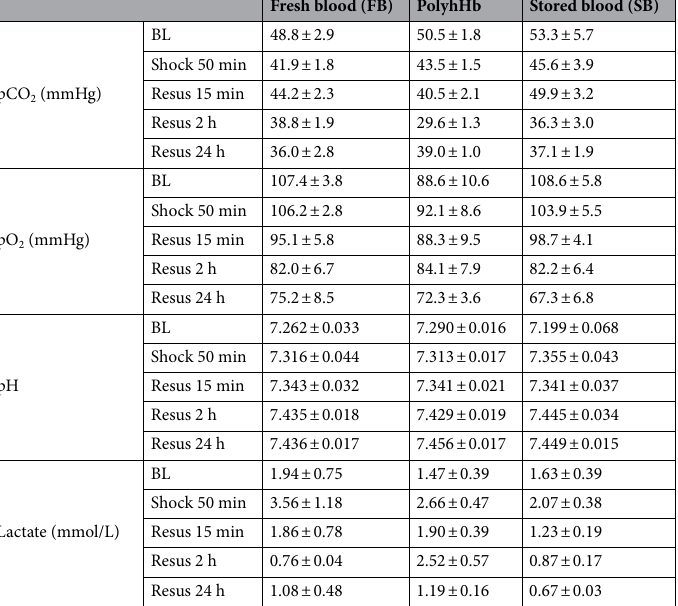
heart compared to the FB ( p < 0.01) and PolyhHb ( p < 0.01) groups (FB: 167.9 ± 6.9; PolyhHb: 151.8 ± 5.6; SB: 109.1 ± 13.4 pg/mg of protein). Cardiac troponin was statistically higher (41%) for the SB group compared to the FB group ( p < 0.01) (FB: 103.8 ± 4.0; PolyhHb: 125.3 ± 2.5; SB: 147.4 ± 15.4 ng/mg of protein), while c-reac- tive protein was no different between groups (FB: 245.2 ± 8.5; PolyhHb: 250.4 ± 9.4; SB: 227.6 ± 16.3 ng/mg of protein). The increased cardiac troponin level indicated cardiac damage caused by resuscitation with stored blood. Surprisingly, ANP levels were 17% lower in the SB group compared to the PolyhHb group (p < 0.01) (FB: 413.1 ± 12.9; PolyhHb: 452.6 ± 19.5; SB: 375.6 ± 16.8 ng/mg of protein). Systemic and splenic inflammatory markers, and catecholamines. Inflammatory responses are expected from blood transfusions, and are exacerbated by transfusion of stored blood and, potentially by PolyhHb 20,23,24 . Plasma and spleen inflammatory markers are presented in Fig. 5. Plasma IL-6 (FB: 288.6 ± 15.3; PolyhHb: 330.2 ± 17.7; SB: 336.1 ± 12.7 pg/mL) and CXCL1 (FB: 223.7 ± 6.0; PolyhHb: 242.1 ± 7.6; SB: 258.6 ± 25.7 pg/mL), two inflam- matory markers, were not statiscally different in the SB and PolyhHb groups compared to the FB group sug- gesting there was no systemic inflammation. In contrast, the SB group presented 45% higher levels of IL-10 (an anti-inflammatory marker) compared to the FB group ( p < 0.01), and 22% higher compared to the PolyhHb group ( p = 0.04) (FB: 251.7 ± 11.3; PolyhHb: 299.8 ± 11.3; SB: 365.0 ± 31.62 pg/mL). Moreover, splenic CXCL1 was higher only in the PolyhHb group by 23% compared to the FB group (p = 0.04), and was no different com- pared to the SB group (FB: 368.3 ± 9.7; PolyhHb: 452.0 ± 17.0; SB: 418.8 ± 45.8 pg/mg of protein). Catecholamines are autonomic nervous system biomarkers and can predict cardiovascular risk 25 . At 24 h after resuscitation, the SB group had sympathetic hyperactivation, as suggested by higher norepinephrine compared to the FB and PolyhHb groups (p < 0.01 and p < 0.01) (FB: 728.3 ± 18.9; PolyhHb: 824.7 ± 50.1; SB: 1055 ± 44.8 pg/ mL). Similarly, epinephrine was higher after resuscitation in the SB group compared to the FB and PolyhHb groups (p < 0.01 and p < 0.01) (FB: 333.6 ± 7.0; PolyhHb: 370.1 ± 11.8; SB: 525.6 ± 64.5 pg/mL). Iron metabolism. Oxidative damage caused by ferryl Hb is one of the major adverse chemical reactions associ- ated with prior generations of HBOCs 26,27 . In the present study, the enzyme ferritin was measured in all organs as well as total bilirubin, in an effort to understand iron metabolism and track possible adverse effects caused by either blood or PolyhHb. Serum, spleen, liver, heart ferritin and bilirubin after resuscitation are presented in Table 2. Serum ferritin, spleen ferritin, and heart ferritin was lower in the SB group compared to the FB ( p < 0.01) group and the PolyhHb group ( p < 0.01). Liver ferritin was lower in the SB group compared only to the PolyhHb group ( p = 0.04). Total bilirubin was lower in the fresh blood group compared to the PolyhHb group ( p = 0.04) and the stored blood group ( p < 0.01).